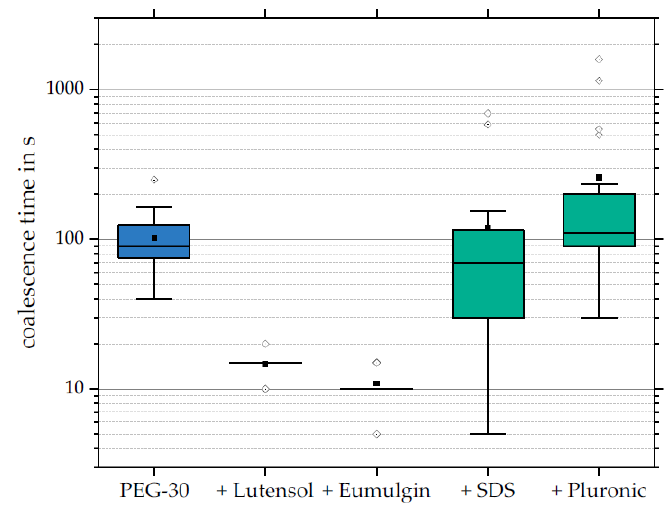
Figure 7. Coalescence time of water droplets stabilized with 0.005 wt% PEG-30 and additionally 0.1 wt% of hydrophilic surfactants in the W2 phase. Boxplot symbols as described in Figure